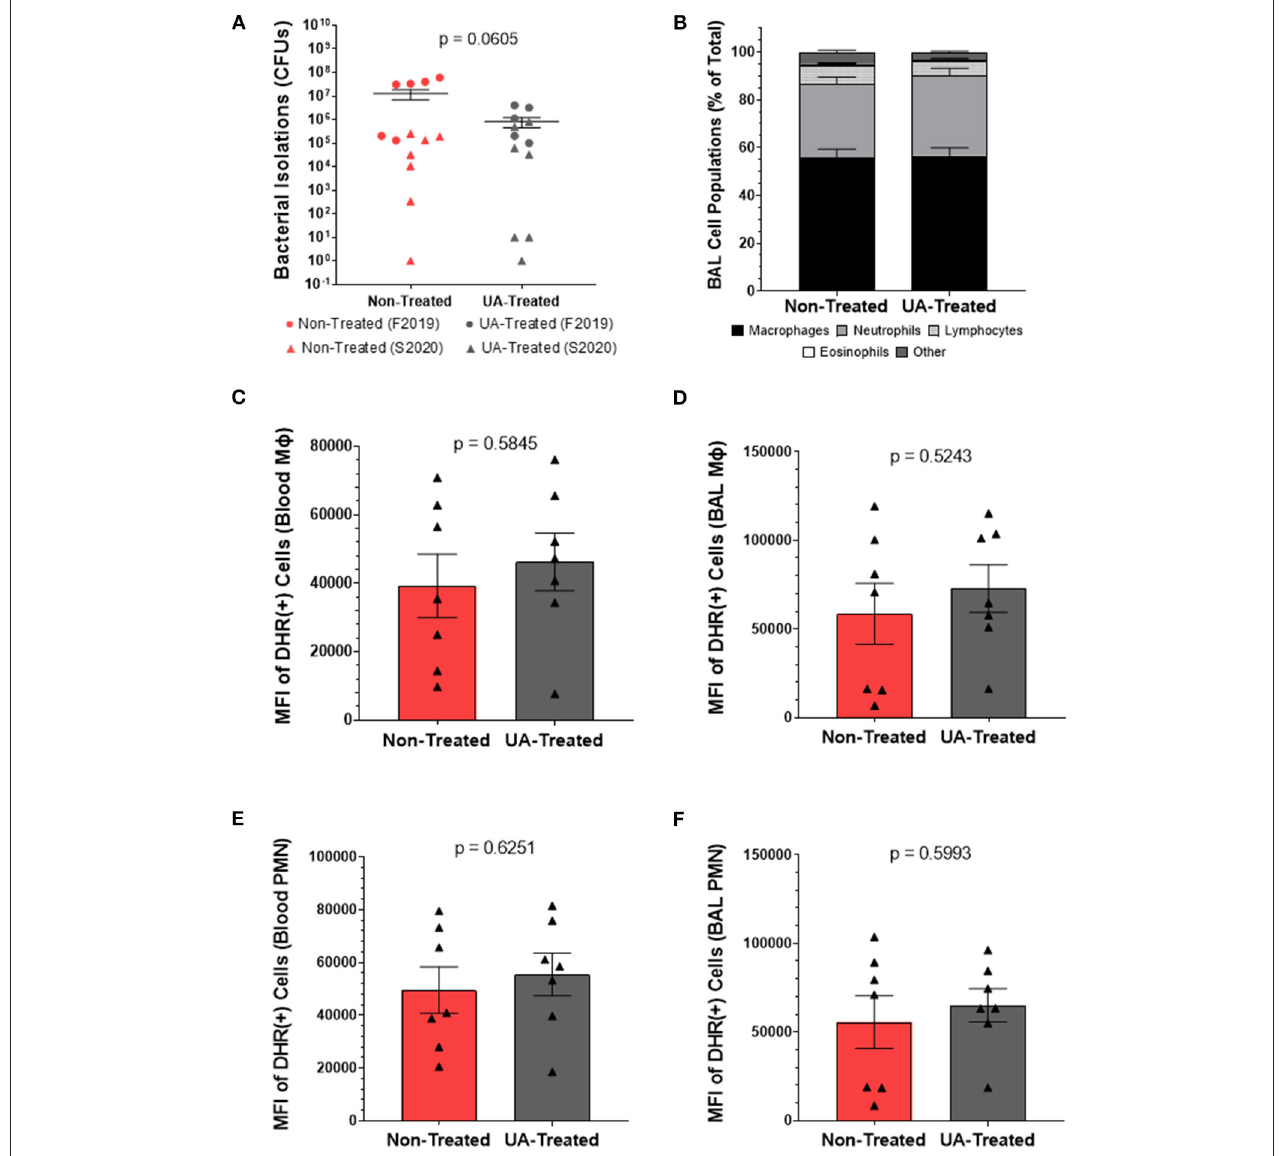
FIGURE 3 | Prophylactic UA treatment reduces bacterial burden following MH infection but does not affect the oxidative burst potential of infiltrating or circulating innate immune cells. (A) Lung sections were collected from 7 predetermined locations around the lung and assayed by quantitative culture to determine the bacterial burden at 4 dpi as described in Briggs et al. (18). Individual animal data from F2019 has been represented as a circle, while S2020 animal data has been represented as a triangle. The average number of colony forming units (CFUs) determined from each animal are plotted on the graph above along with the average CFUs ± the SEM for each treatment group (non-treated n = 13, UA-treated n = 12). (B) BAL fluid was collected at 4 dpi and subjected to cytology analysis to quantify neutrophils, macrophages, lymphocytes, eosinophils, and other cell types infiltrating the lung airways. The graph depicts the mean relative frequencies of cell types ± SEM for each treatment group (non-treated n = 14, UA-treated n = 13). (C–F) Whole blood and BAL fluid were collected for DHR assays at 4 dpi to determine the oxidative burst potential of circulating macrophages (C) , BAL macrophages (D) , circulating neutrophils (E) , and BAL neutrophils (F) in the two treatment groups; these data were only collected during the S2020 study, thus individual animal data is represented with a triangle symbol ( N ). Cells were stimulated with PMA or remained unstimulated for 30min. Cells were then surface stained with monoclonal antibodies to detect monocytes (anti-bovine CD14) and granulocytes (anti-bovine CH138A) and fixed for flow cytometry analysis. These figures depict the average 1 MFI (MFI of PMA stimulated minus MFI of unstimulated wells) ± SEM of DHR labeled and PMA stimulated cells. Data represent animals from the S2020 study only (non-treated n = 7, UA-treated n = 7). neutrophils, lymphocytes, eosinophils, and other cell